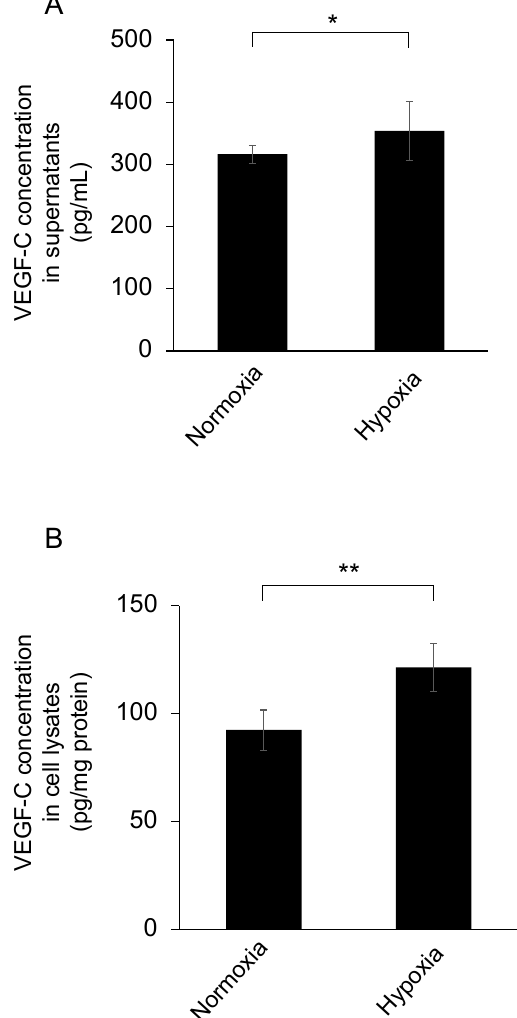
Figure 4. Effect of hypoxia on VEGF-C concentrations in trabecular meshwork cells. Trabecular meshwork cells were cultured under normoxic or hypoxic conditions for 24 h. Additionally, VEGF-C concentrations in the supernatants ( A ) and the cell lysates ( B ) were detected using ELISA. VEGF-C concentrations in trabecular meshwork cells under hypoxic condition were significantly elevated compared with those in normoxic condition in both the supernatants and the cell lysates ( n = 6 in each group, * p < 0.05, ** p < 0.01). VEGF-C concentrations in both supernatants and cell lysates of TM cells which had been cultured in high glucose media were significantly higher than those in low glucose media ( n = 6 in each group, p < 0.01) (Figure 5A,B).